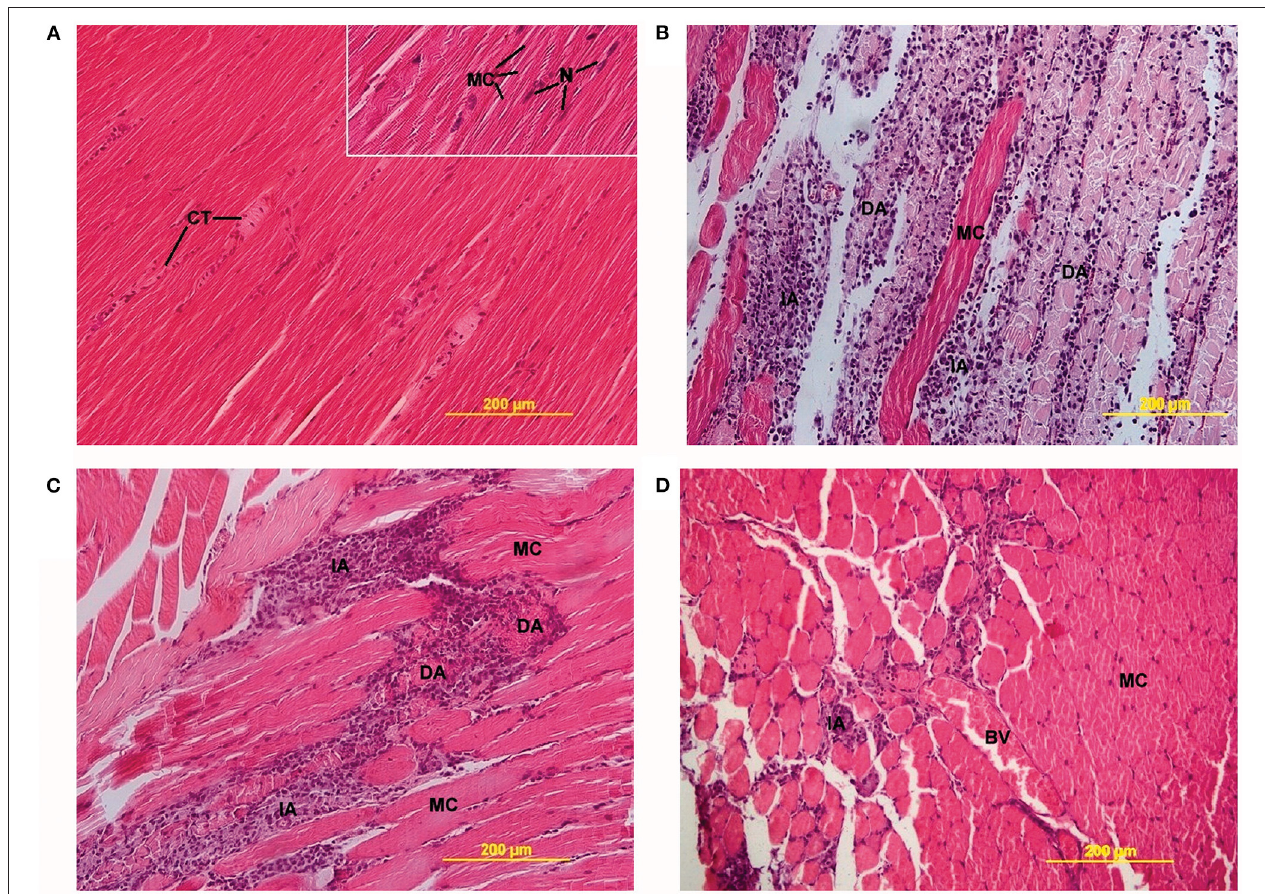
FIGURE 2 | Light microscopy images of LA-induced myotoxicity. (A) Skeletal muscle 2 days after 0.9% saline injection, showing connective tissue (CT) between normal muscle fibers (MC) (20 × magnification, insert 40 × ). (B) Skeletal muscle 2 days after 0.5% bupivacaine injection, showing degenerative (DA) and inflammatory areas (IA) alternated with MC (20 × magnification). (C) Skeletal muscle 2 days after 0.5% ropivacaine injection, also displaying DA and IA (20 × magnification). (D) Skeletal muscle 2 days after 0.5% levobupivacaine injection, showing incidental IA and blood vessels (BV) between MC (20 × magnification). Öz Gergin et al. Comparison of the Myotoxic Effects of Levobupivacaine, Bupivacaine, and Ropivacaine: An Electron Microscopic Study. Ultrastructural Pathology, May 2015. Reprinted by permission of the publisher (Taylor & Francis Ltd.) (34).